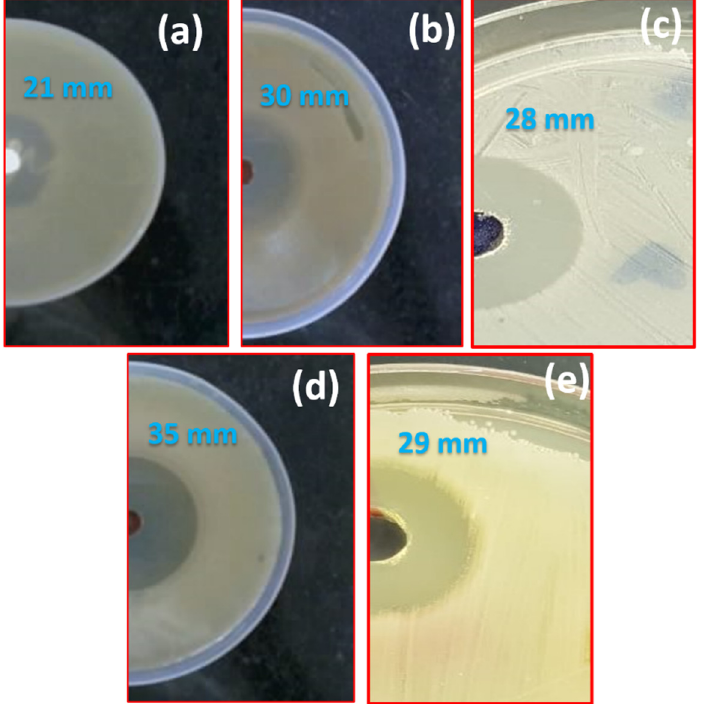
Figure 4. Zone of inhibition obtained with silver nanoparticles for ( a ) E. coli , ( b ) S. aureus, and ( c ) K. pneumoniae , ( d ) P. aeruginosa , and ( e ) C. albicans . ( c ) K. pneumoniae , ( d ) P. aeruginosa , and ( e ) C. albicans